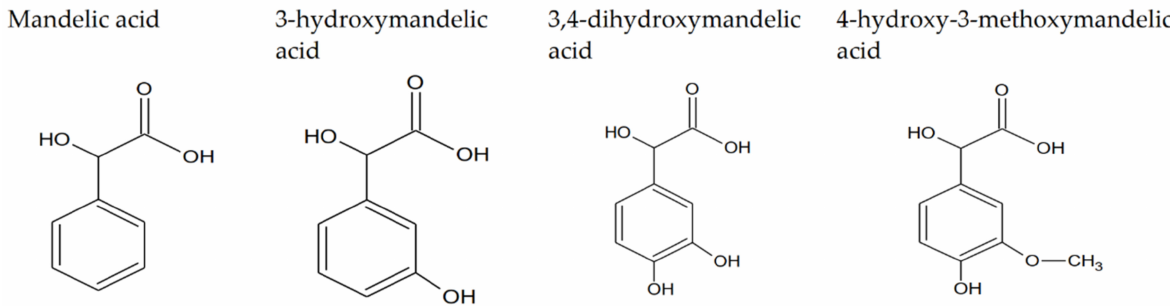
Figure 1. The structure of mandelic acid and its hydroxy and methoxy